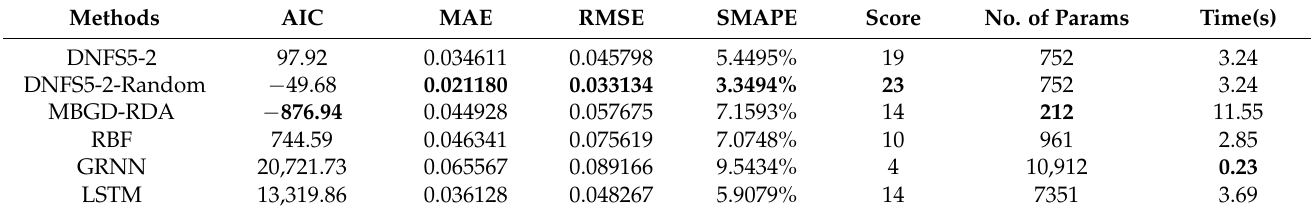
Table 9. The performance of different algorithms on Test Dataset No. 2.